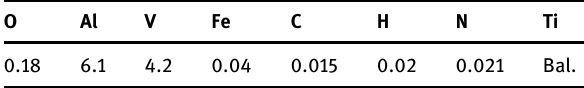
Table 1: Main components of the TC4 titanium alloy powder ( wt% )